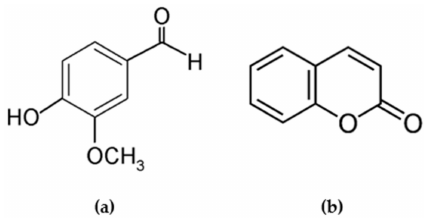
Figure 1. Structure of ( a ) vanillin and ( b )